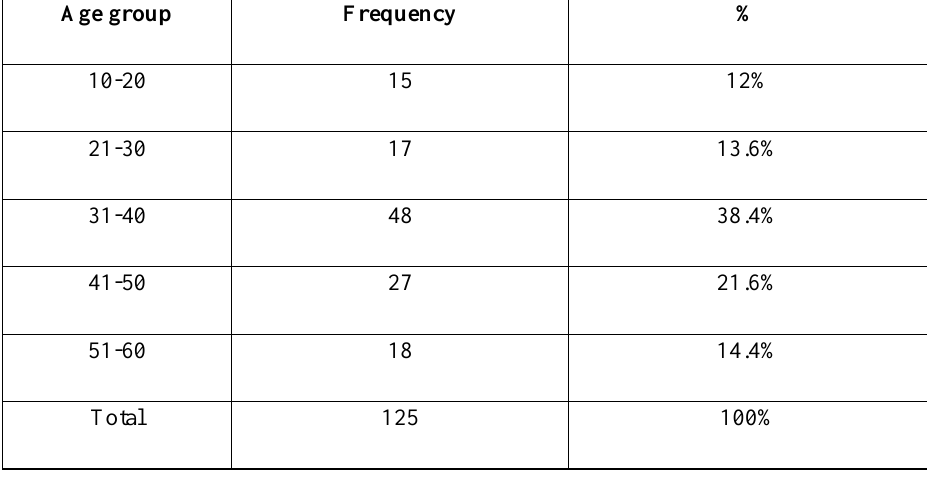
Table 1. Prevalence of Trichomonas vaginalis among Sudanese patients according to